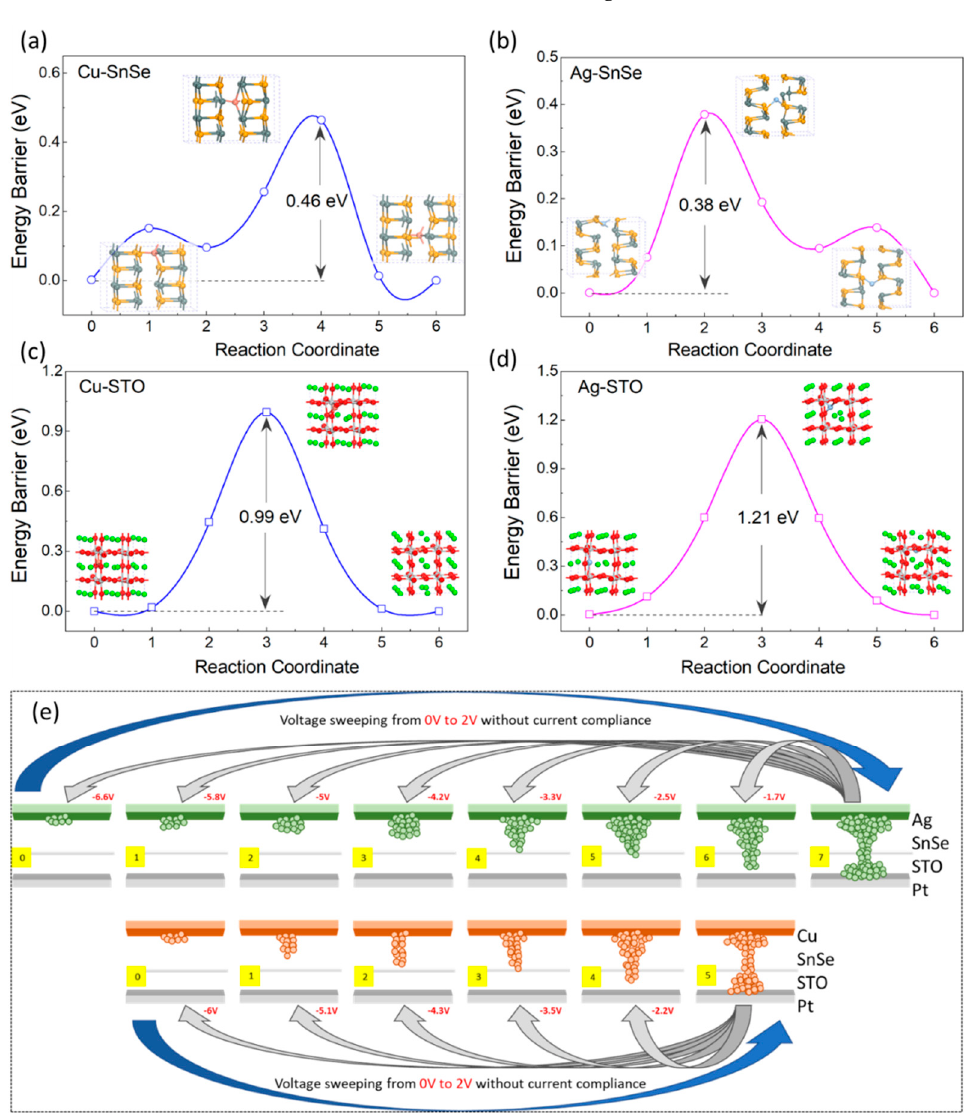
Figure 5. ( a ) The diffusion path and the energy barrier for Cu ions and ( b ) Ag ions diffused from the top electrode into SnSe. ( c ) The diffusion path and the energy barrier for Cu ions and ( d ) Ag ions diffused from the SnSe/STO interface into STO. ( e ) The switching mechanism of the Cu/SnSe/STO/Pt device and Ag/SnSe/STO/Pt device. The blue arrows indicate that both devices are switched from HRS to LRS by voltage sweeping without current compliance, and the gray arrow indicates that the multistate can be achieved by negative voltage pulse in different values.